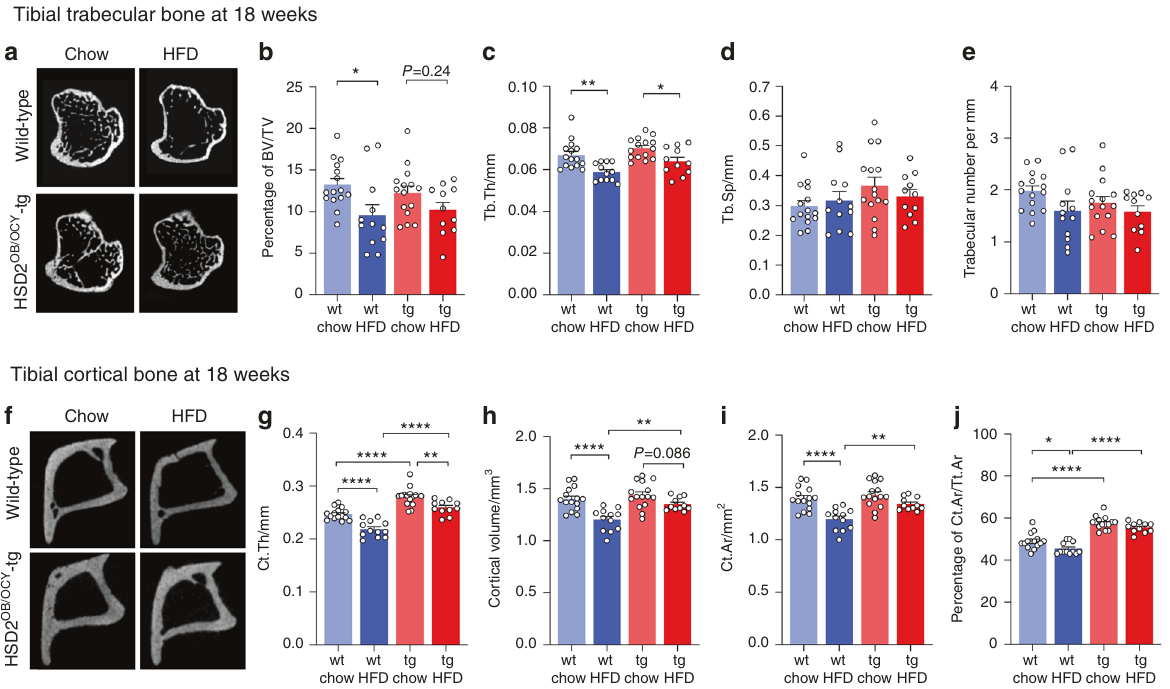
Fig. 2 Disrupting glucocorticoid signaling in osteoblasts and osteocytes prevented HFD-induced loss of trabecular and cortical bone. a Sections of tibial trabecular bone from male wild-type (wt) and HSD2 OB/OCY -tg (tg) mice fed either chow or HFD for 18 weeks. b – e Micro-CT results are shown as scatterplots, with the mean ± SEM shown in columns, n = 11 – 15/group, as shown. b Bone volume/total volume (BV/TV) in trabecular bone; the effect of diet was highly signi fi cant ( F 1,49 = 9.511, P = 0.003 4). c Trabecular thickness (Tb.Th.); the effect of diet was highly signi fi cant ( F 1,49 = 20.50, P < 0.000 1), and the effect of genotype was signi fi cant ( F 1,49 = 7.010, P = 0.011). d Trabecular spacing (Tb.Sp.). e Trabecular number (Tb.N.); the effect of diet was signi fi cant ( F 1,49 = 4.367, P = 0.042). f Sections of tibial cortical bone from male wild-type (wt) and HSD2 OB/OCY -tg (tg) mice fed either chow or HFD for 18 weeks. g – j Cortical micro-CT measurements of n = 11 – 15/group, as shown: g Cortical thickness (Ct.Th); the effects of diet and genotype were both highly signi fi cant (diet: F 1,49 = 36.15, P < 0.000 1, genotype: F 1,49 = 83.45, P < 0.000 1). h Cortical volume; the effects of diet and genotype were highly signi fi cant (diet: F 1,49 = 23.43, P < 0.000 1, genotype: F 1,49 = 10.03, P = 0.002 7). i Cortical area (Ct.Ar); the effects of diet and genotype were highly signi fi cant (diet: F 1,49 = 24.34, P < 0.000 1, genotype: F 1,49 = 9.878, P = 0.002 8). j Cortical area fraction (Ct.Ar/Tt.Ar); the effects of diet and genotype were highly signi fi cant (diet: F 1,49 = 11.16, P = 0.001 6, genotype: F 1,49 = 119.9, P < 0.000 1). Signi fi cance was determined using two-way ANOVA, with the Tukey ’ s multiple comparison test used for post hoc testing. In all cases, * P < 0.05, ** P < 0.01, *** P < 0.001, and **** P < 0.000 1 for HSD2 OB/OCY -tg mice (8.6-fold vs. chow), but this did not occur in wild-type mice (Fig. 3e). Consistent with increased osteoblast activity, serum procollagen type I N-terminal propeptide (PINP) levels were signi fi cantly increased in HSD2 OB/OCY -tg mice after 18 weeks of HFD feeding, indicative of increased bone formation (Fig. 3f). Changes in bone mass also depend on changes in bone resorption. Both the osteoclast surface (effect of genotype: P = 0.000 8, Fig. 3g) and osteoclast number (effect of genotype: P = 0.027, Fig. 3h) were signi fi cantly lower in HSD2 OB/OCY -tg mice than in wild-type mice. The effects of diet on these parameters were not signi fi cant, however. Serum concentrations of TRAB5b, a marker of osteoclast activity, were not affected by either diet or genotype (Fig. 3i). HFD feeding enhances skeletal Wnt signaling in HSD2 OB/OCY -tg mice Wnt signaling is critical for bone formation 27 and may be in fl uenced by HFD feeding. 10 We therefore investigated skeletal Wnt signaling pathways in wild-type and transgenic mice fed either chow or HFD by measuring mRNA and protein expression levels of Sost /sclerostin, β -catenin staining in sections of trabecular bone, and mRNA expression of the nuclear effectors of canonical Wnt signaling Tcf7/Tcf1 and Tcf7l2 / Tcf4 and the osteogenic factor Bmp4 . In wild-type mice, skeletal Sost mRNA expression was increased 8.3-fold by HFD feeding but remained unchanged in HFD-fed HSD2 OB/OCY -tg mice (diet × genotype interaction: